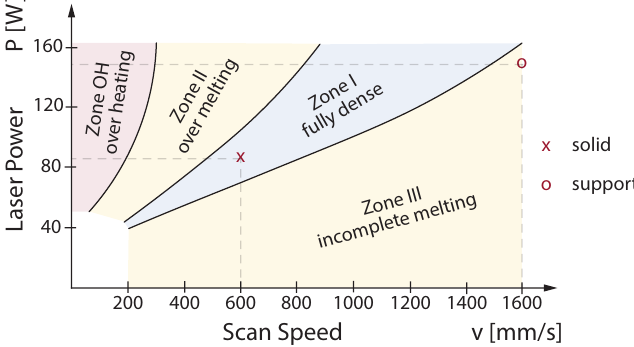
Figure 1. Process parameter relationships for L-PBF manufactured Ti-6Al-4V. Adapted from